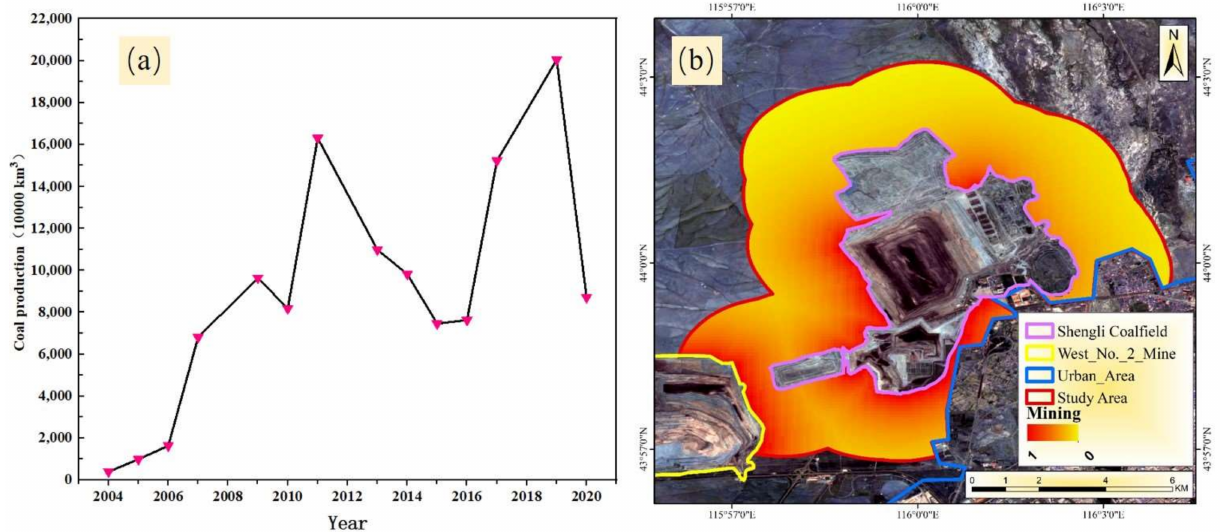
Figure 6. ( a ) Coal production from 2004 to 2020; ( b ) quantitative results of the mining factor in 2020 (normalized).